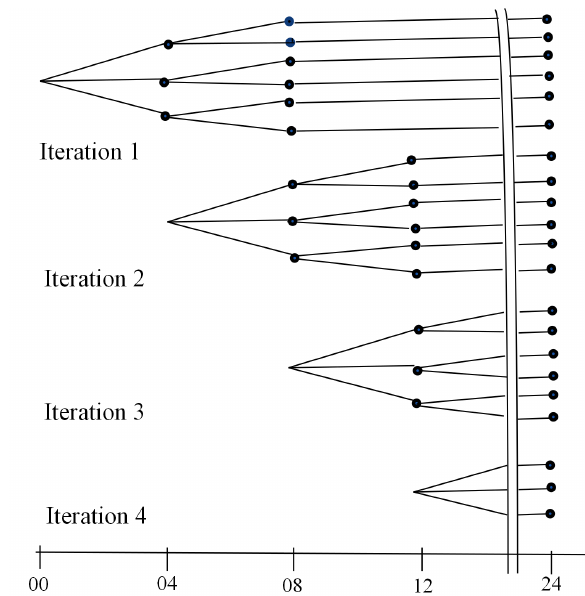
Figure 2. Illustration of the rolling planning approach implemented in the two-stage optimal bidding